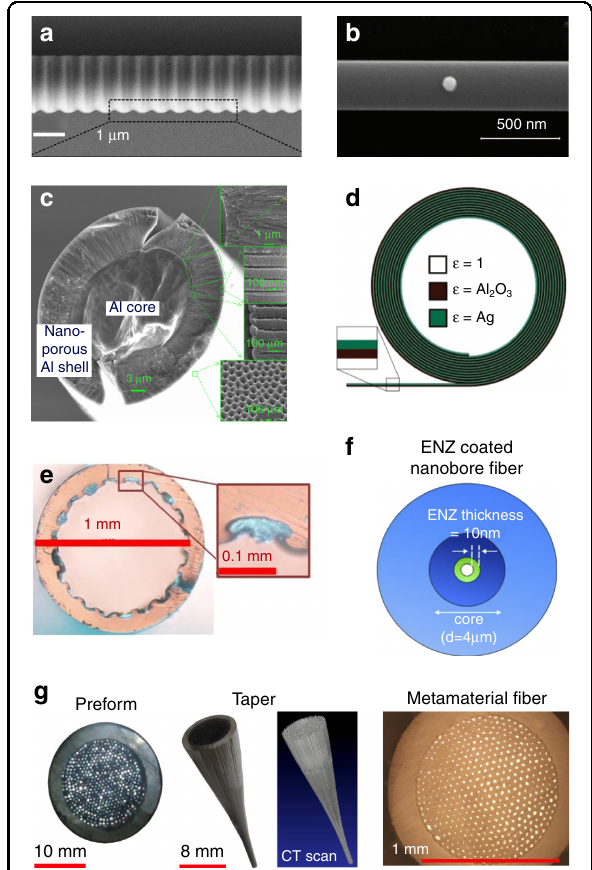
Fig. 6 Optical meta- fi bers. a Fiber gratings with subwavelength feature size 236 . b Air-clad silica nano fi ber with a gold nanoparticle resting on its surface 238 . c SEM image of the metamaterial fi ber with aluminum core and radially oriented nanopores 274 . d Cross-section schematic of a rolled-up Al 2 O 3 /Ag bilayers hollow fi ber 240 . e Microscope image of the fi ber facet with subwavelength indium wires uniformly embedded in Zeonex host around the hollow-core 243 . f